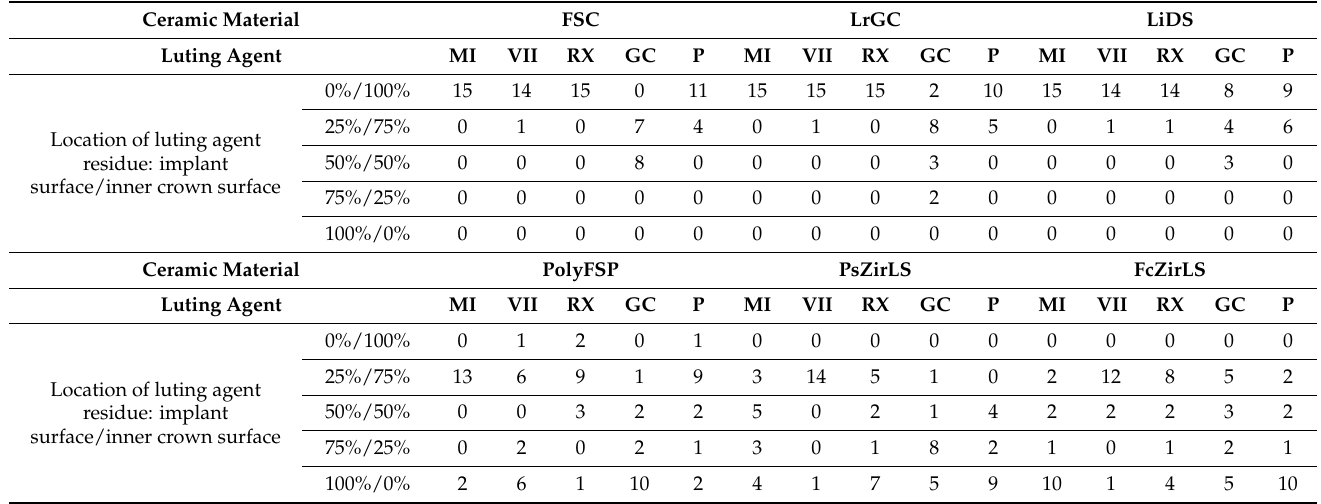
Table 4. Location of luting agents’ residue (MI: Multilink Implant, VII: Variolink II, RX: RelyX Unicem, GC: Fujicem, P: